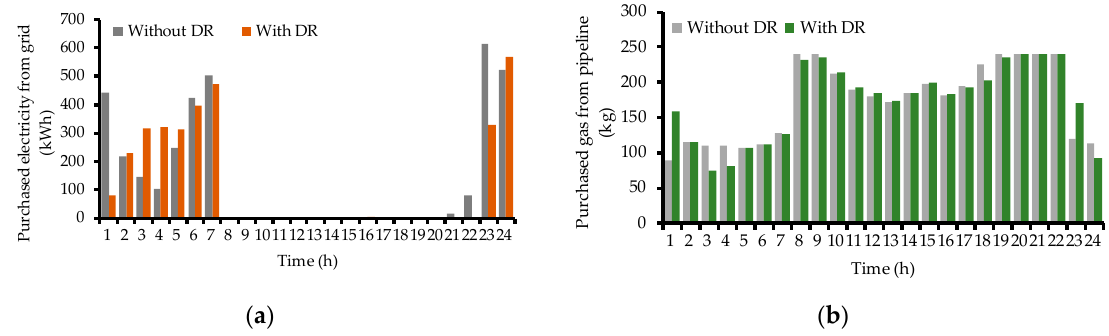
Figure 7. The purchased electricity and natural gas: ( a ) purchased electricity; ( b ) purchased gas. Energies 2019 , 12 , x FOR PEER REVIEW